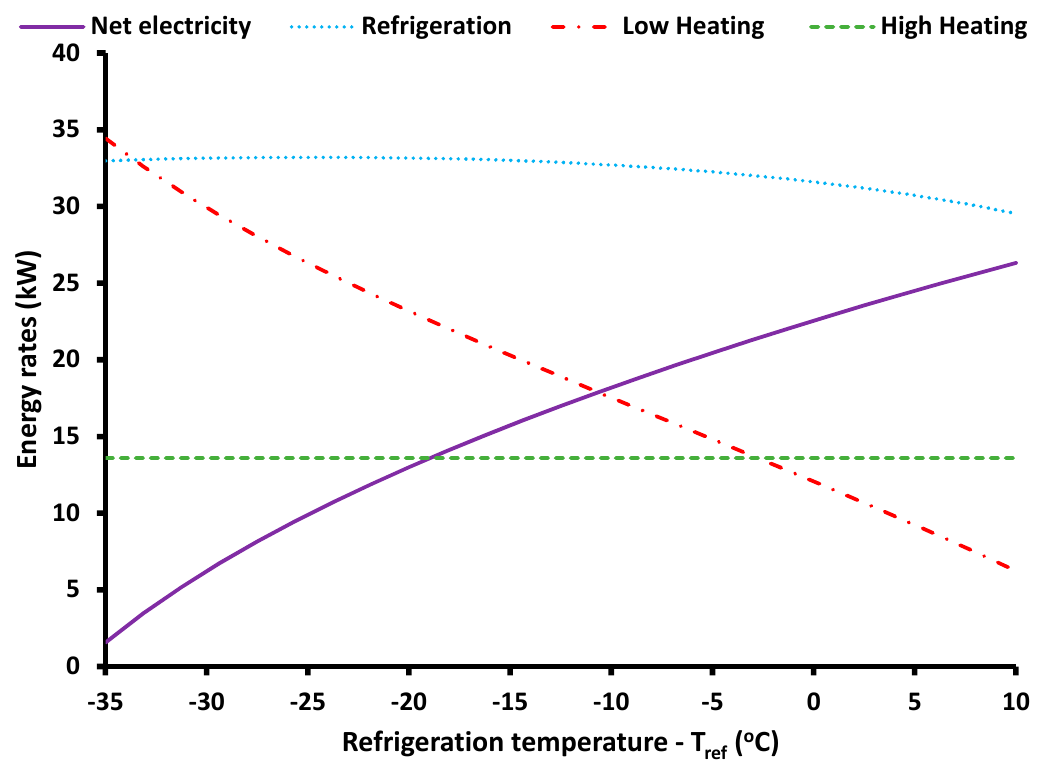
Figure 12. Useful energy products for different values of the refrigeration temperature.